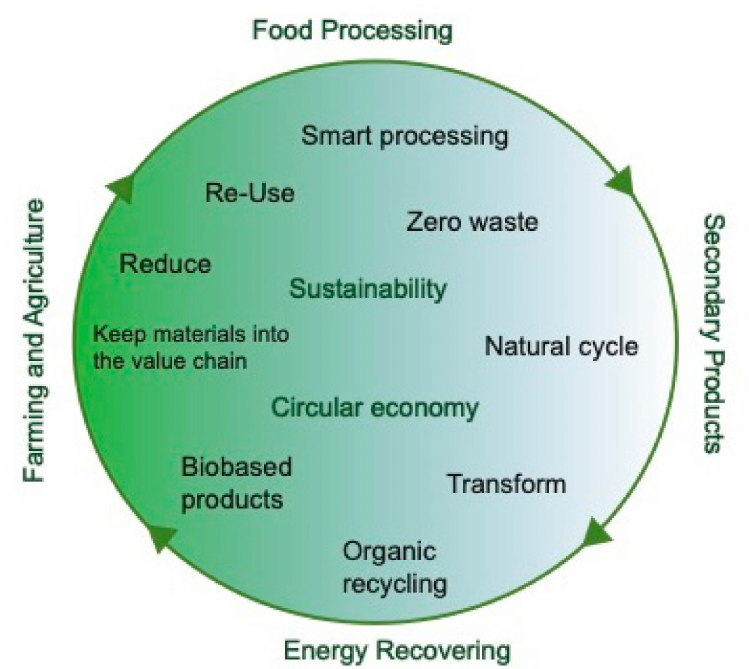
Figure 1. The role of cold plasma technology in a circular